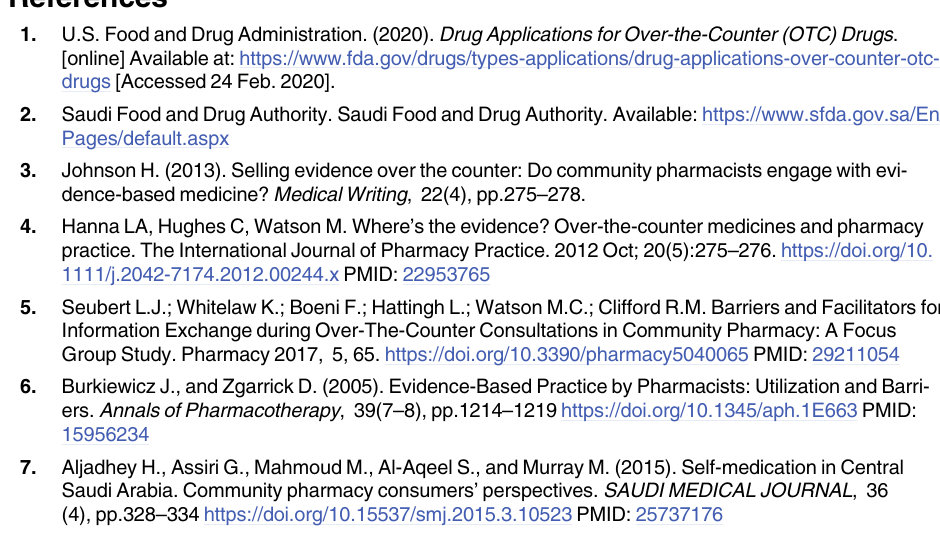
S1 Table. Focus group final coding